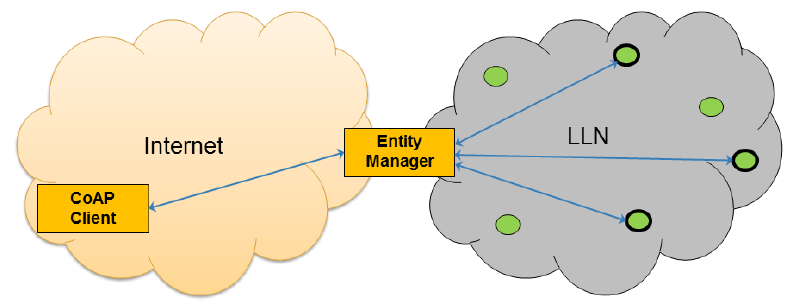
Figure 3. Clients create entities consisting of several smart object resources on the entity